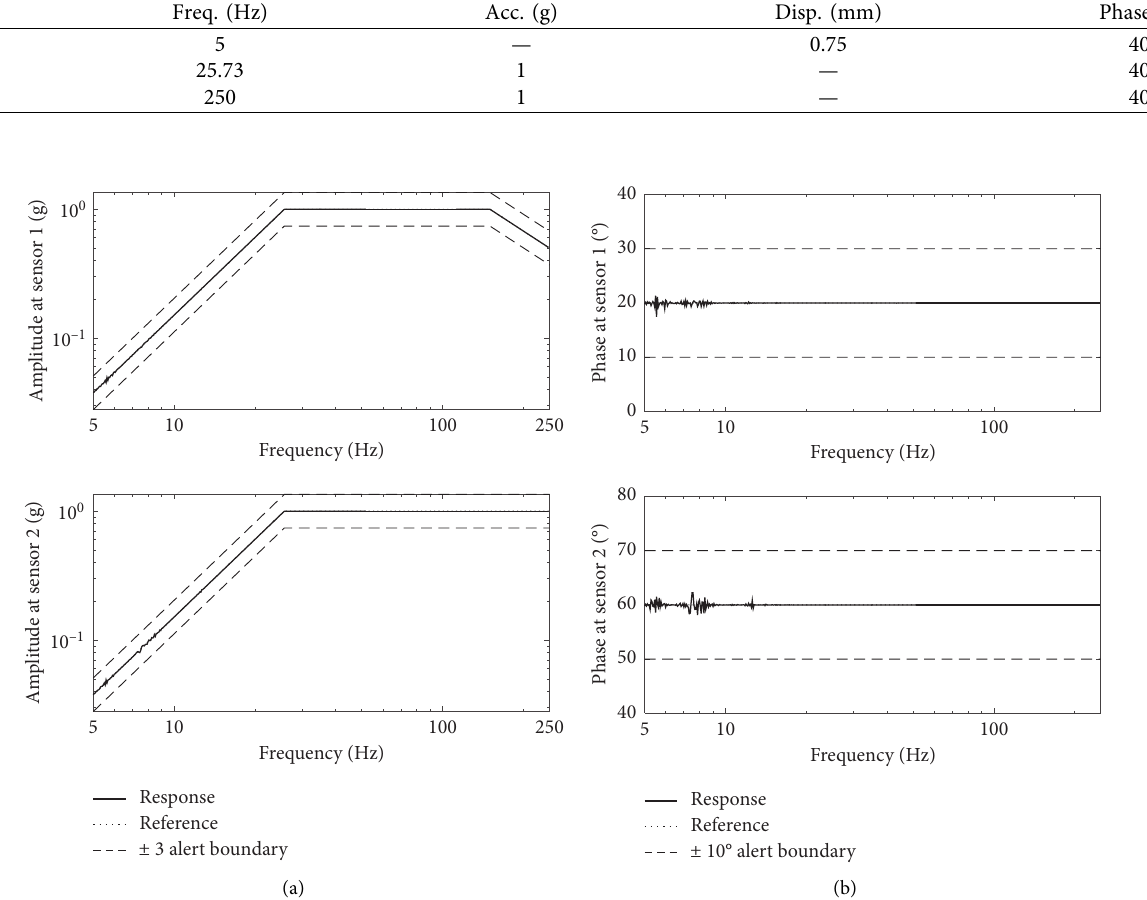
Figure 6: Simulation results of the two-input-two-output swept-sine vibration test